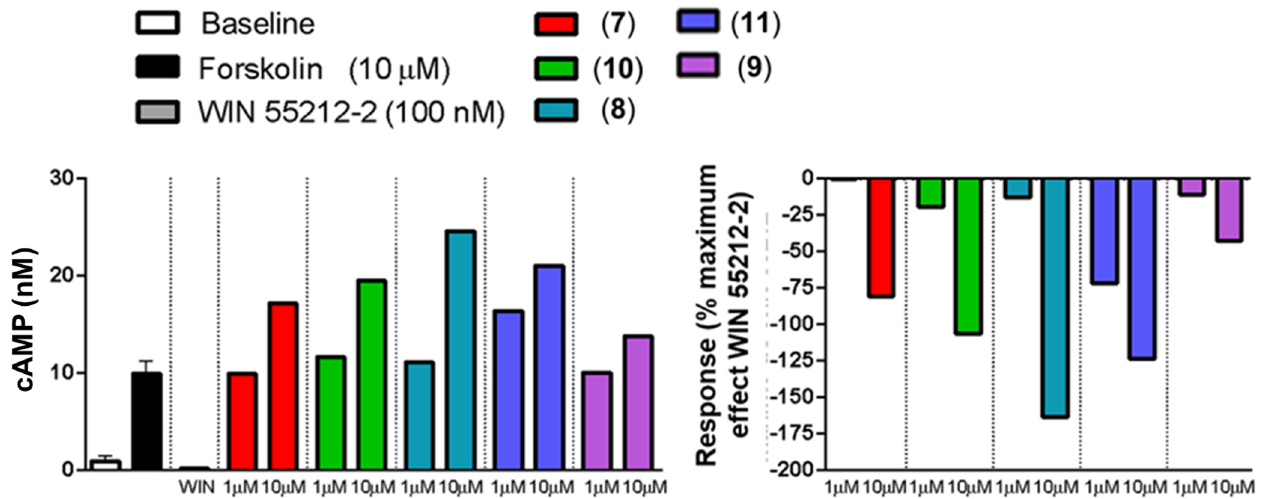
Figure 5. Effect of NSAID-pyrazolamides 7 – 11 on cyclic AMP intracellular concentration of CB 2 - transfected CHO cells after stimulation with 10 µM forskolin. Data represent results from single replicates.